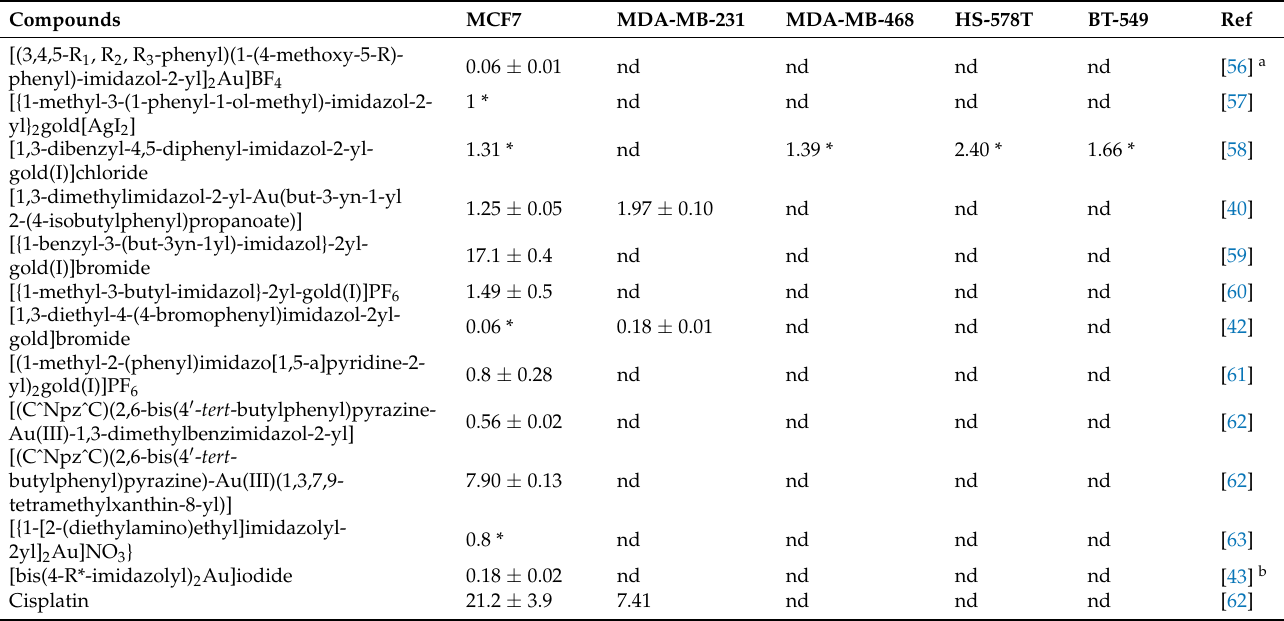
Table 2. IC 50 or IG 50 (micromolar) of selected carbene gold(I) compounds against breast cancer cell